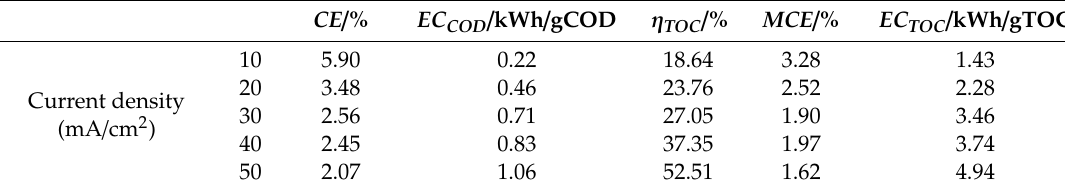
Table 2. E ff ect of di ff erent factors on ARG degradation by using the 2.5D electrode system. CE /